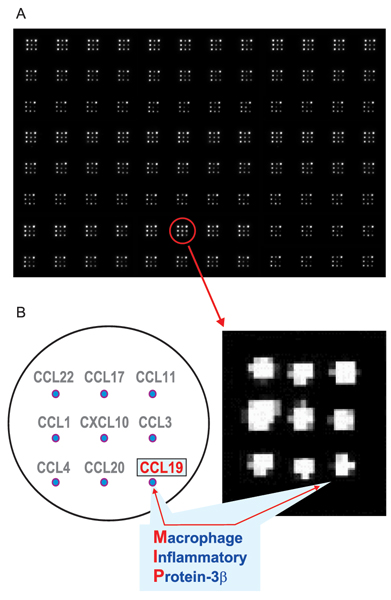
Mini-array, sandwich-type, enzyme-linked immunosorbent assay for chemokine detection. (A) Rows and columns in the image represent wells, of 96-well polystyrene plate, in the bottom of which monoclonal antibodies (mAbs) were spotted in a 3 × 3 pattern. After detection the plate was imaged with cooled charge-coupled device (CCD) camera. (B) Location of anti-chemokine mAb spots in the mini-array and CCD camera image of a 3 × 3 mini-array within a single well. Among nine of the studied chemokines it is CCL19 (also previously known as MIP-3β) which was significantly decreased in sera of patients with preterm labor (see the text for full details).